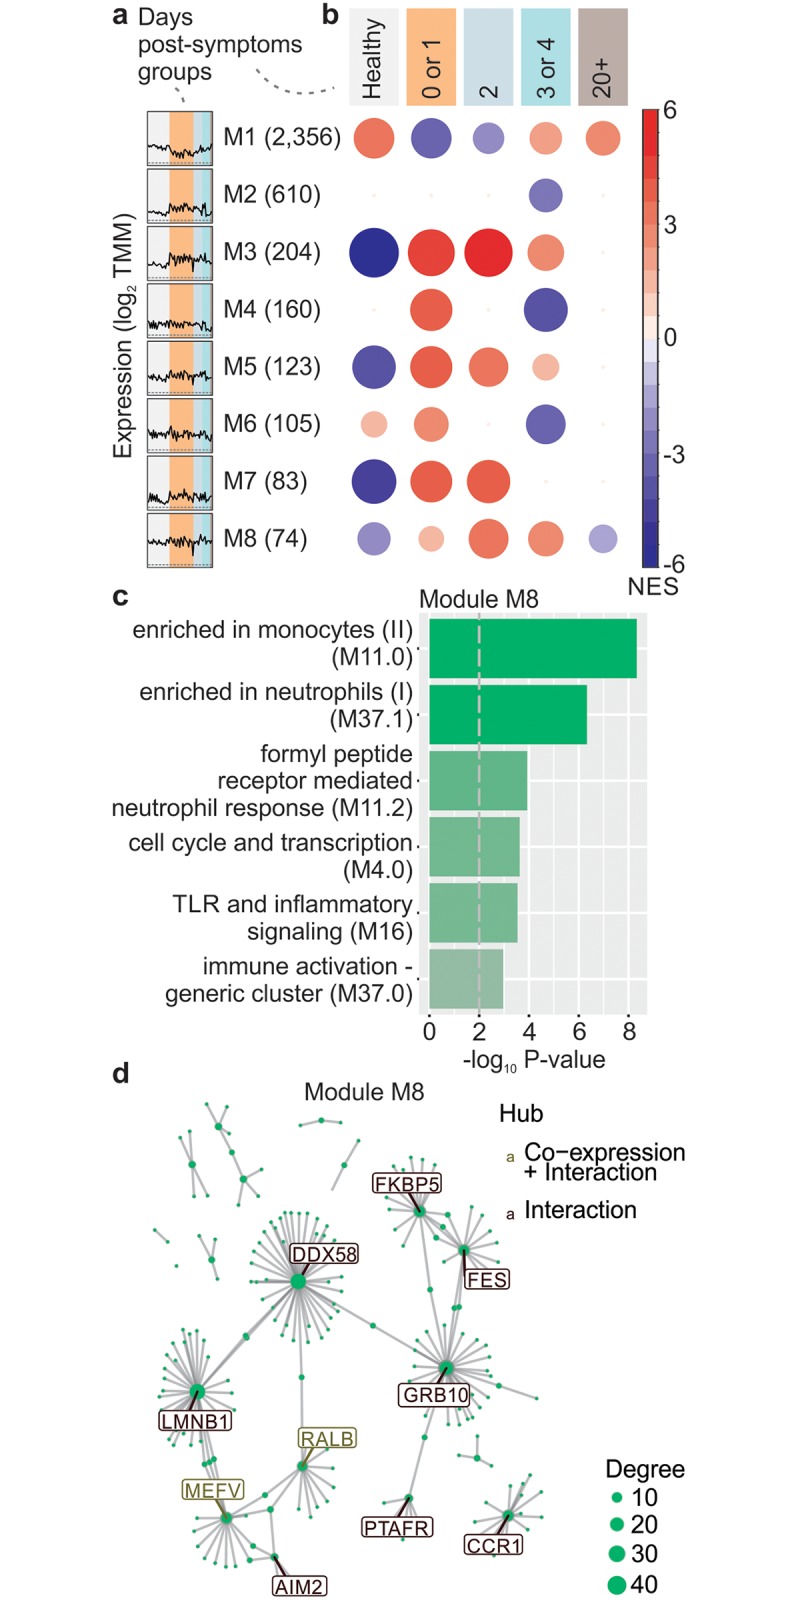
Modular analysis of CHIKV infection.(a) Expression profile of all the eight modules obtained through the CEMiTool analysis. The colors of rectangles represent the days post the onset of symptoms, and the black line represents the mean expression of all the genes inside the module. (b) Results of the gene set enrichment analysis showing the module activity for each subgroup. The size and color of the circles represent the normalized enrichment score (NES). (c) Over-representation analysis of module M8 using BTM pathways as gene sets. The pathways were ordered by significance as indicated on the x-axis. (d) Gene network of module M8 for the top ten most connected genes (hubs) represented as nodes and their protein-protein and co-expression interactions as edges. The size of the node represents its degree of connectivity.